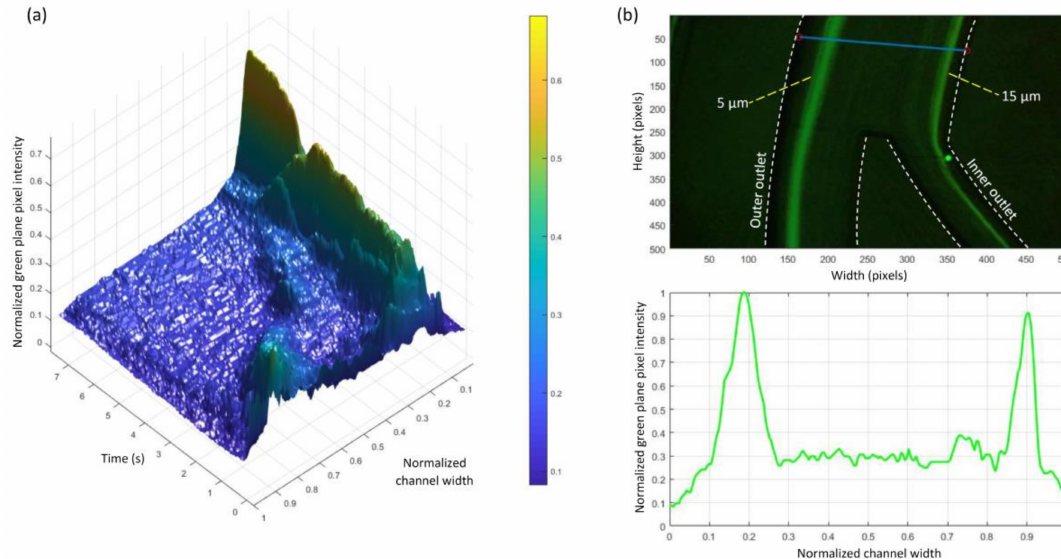
Figure 6. ( a ) 3D green-plane intensity profile of experimentally focusing 5 µ m particles when increasing flow rate from 0 to 5 mL · min − 1 over a period of around 8 s; ( b ) 5 µ m and 15 µ m particles separation using the proposed trapezoidal spiral channel ( top ) image captured with the inverted fluorescence microscope at 5 mL · min − 1 ( bottom ) green intensity profile shows the focusing peaks (each block on the x -axis is equal to 60 µ m of the real channel